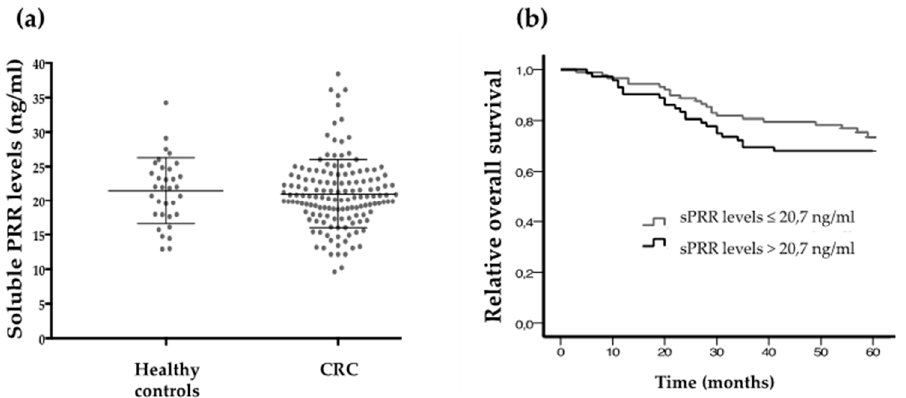
Figure 5. Soluble PRR concentration in plasma samples. ( a ) SPRR plasma concentrations (ng/mL) comparing healthy controls and CRC cases. ( b ) 5-year overall survival in patients expressing high and low sPRR levels (cut-off point at 20.7 ng/mL) (Log-rank test p = 0.271).